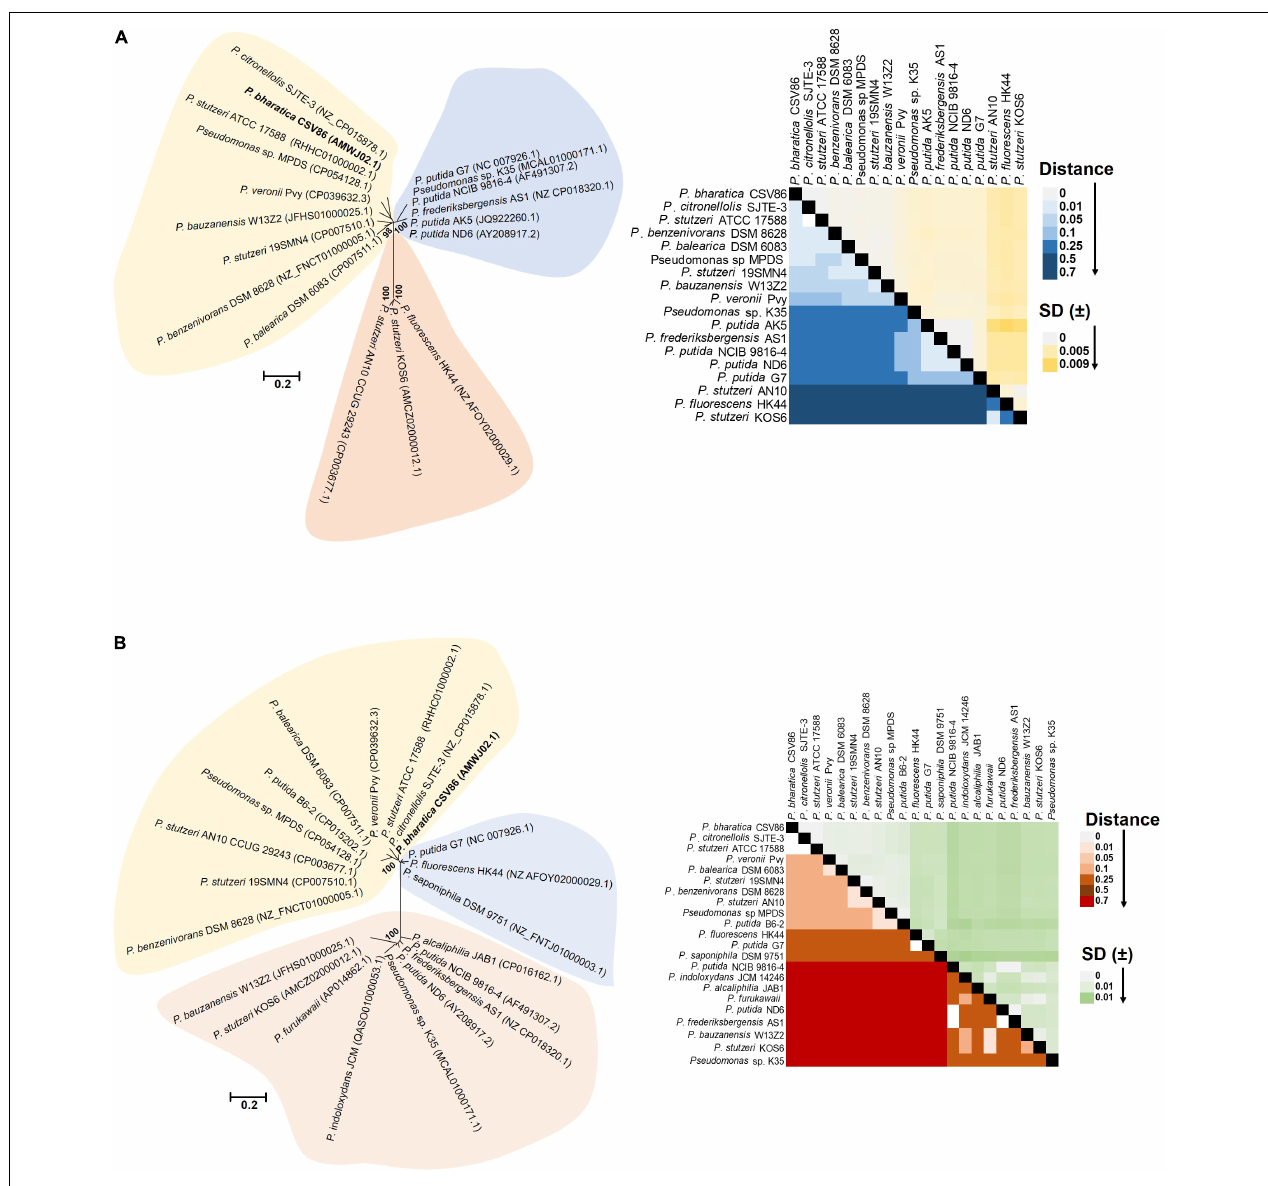
FIGURE 5 | Phylogenomic analyses of cargo gene modules ( nah-sal cluster) of ICE nah CSV86 and other mobile elements (probable ICEs, plasmids, transposons) from naphthalene degrading Pseudomonas spp. Phylogenetic trees of (A) nah cluster and (B) sal cluster are reconstructed using ML-based algorithm and validated using NJ, ME methods with 1,000 bootstrap iterations. The tree is optimized using interactive Tree of Life (iTOL), and the best optimum tree is depicted here. The color-shaded areas around the clades depict demarcation of differential cladding of clusters present on probable ICEs (light yellow), plasmids (light blue), and mixed elements (light pink, which include conjugative/non-conjugative transposons and intermediate forms). The heat-maps depict the p -distance based pairwise similarity of (A) nah clusters and (B) sal clusters located on various mobile genetic